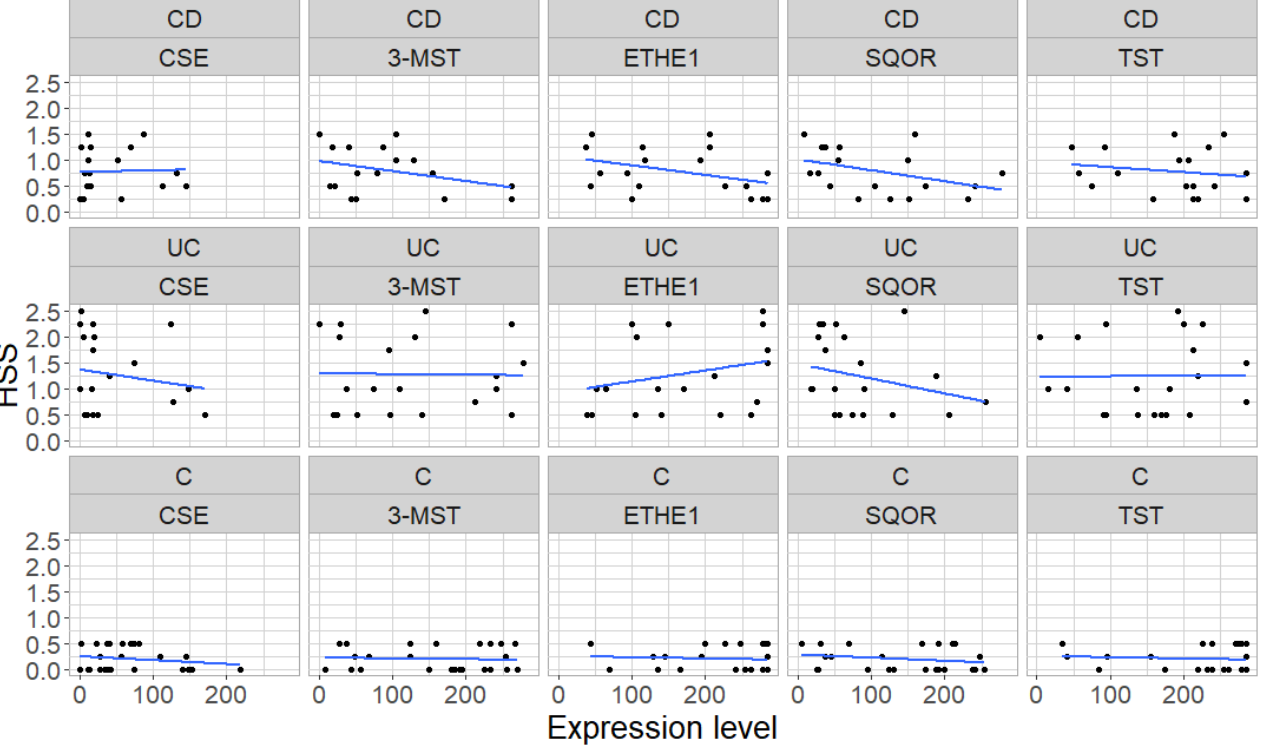
Figure A2. Expression levels of cystathionine- γ -lyase (CSE), 3-mercapto-sulfurtransferase (3-MST), ethylmalonic encephalopathy 1 protein (ETHE1), Sulfide:quinone oxidoreductase (SQOR) and thi- osulfate sulfurtransferase (TST) of biopsies from the rectum compared to the histologic severity score (HSS) of each sample, separated into ulcerative colitis (UC) and controls (C).